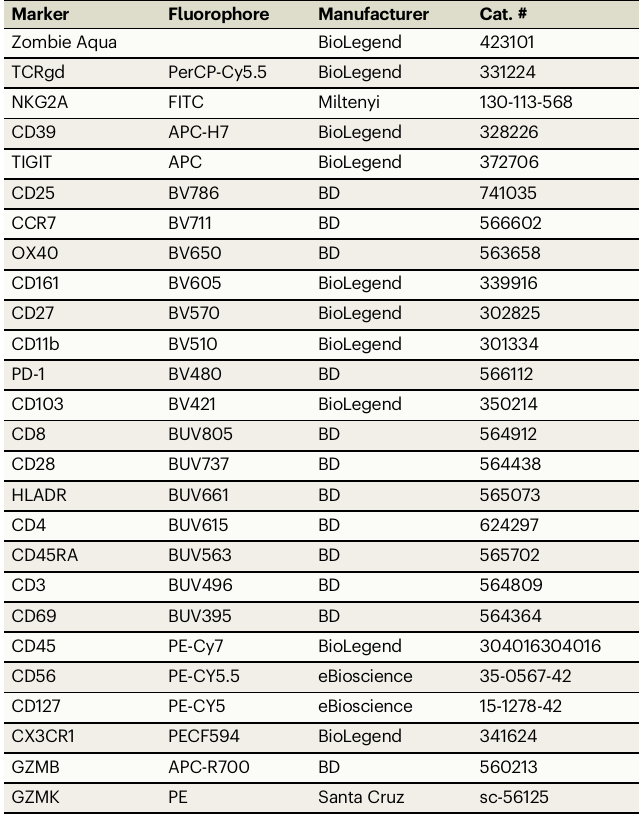
Table 2 | Multiparametric fl ow cytometry